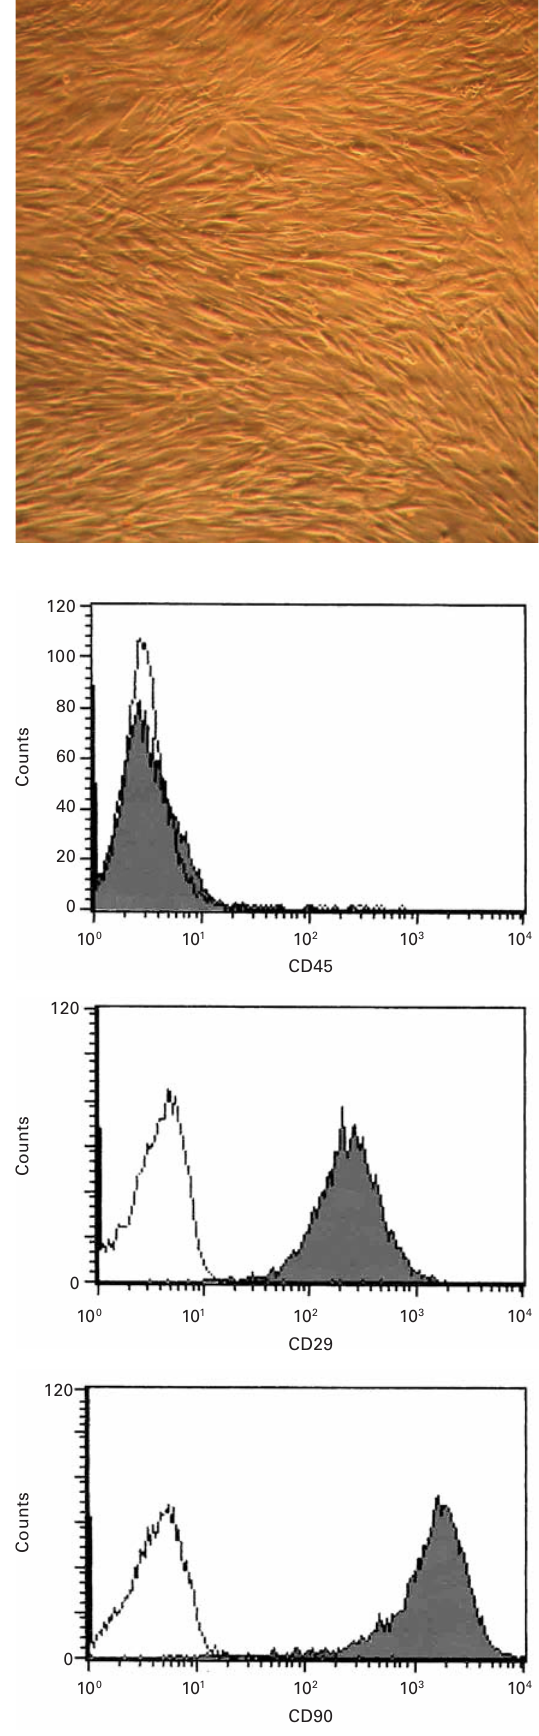
Under an inverse mi- croscopy (×100), Cul- ture bone marrow mesenchymal stem cells (MSCs) (P3) de- rived from rat appear as uniform fibroblast- like cells with slim bodies.